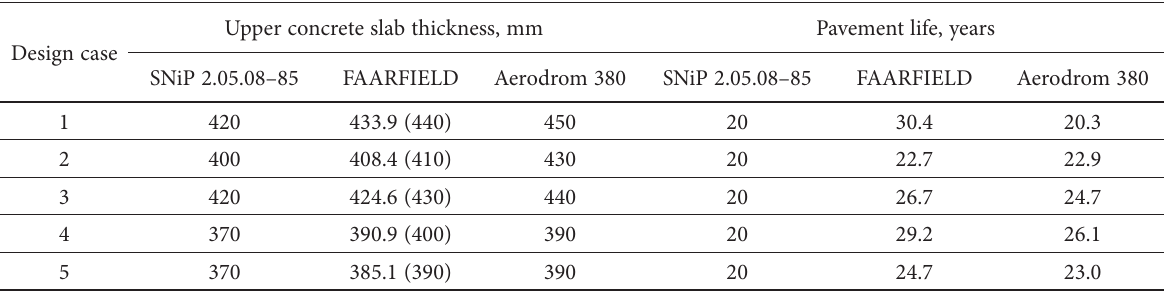
Table 3. Comparative results of slab thickness design in FAARFIELD and “Aerodrom 380”